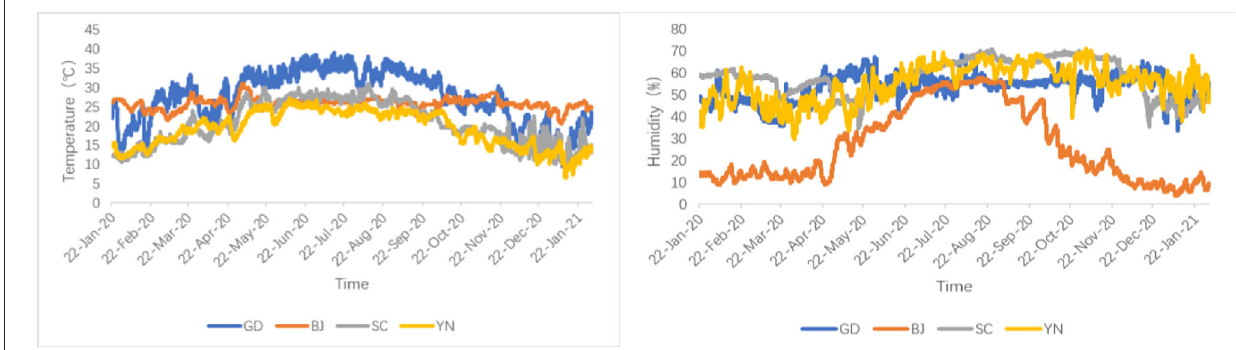
FIGURE 1 | Temperature and humidity curve of the aging process in different areas.